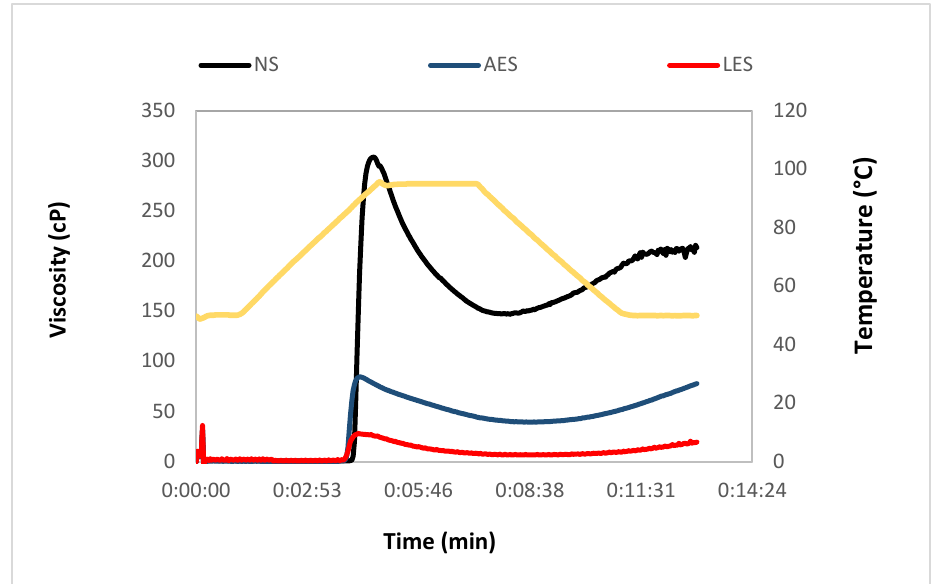
Figure 3. RVA viscogram of native and organic acid − treated talipot starches.